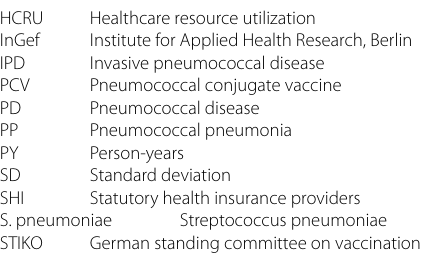
Table 3. Definitions of AOM